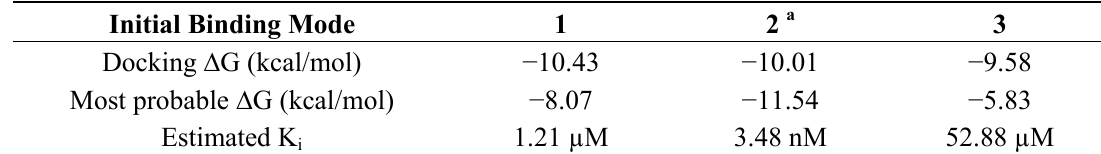
Table 2. Estimated binding free energies of VP-16 in the cleavage complex of TOP2- α .